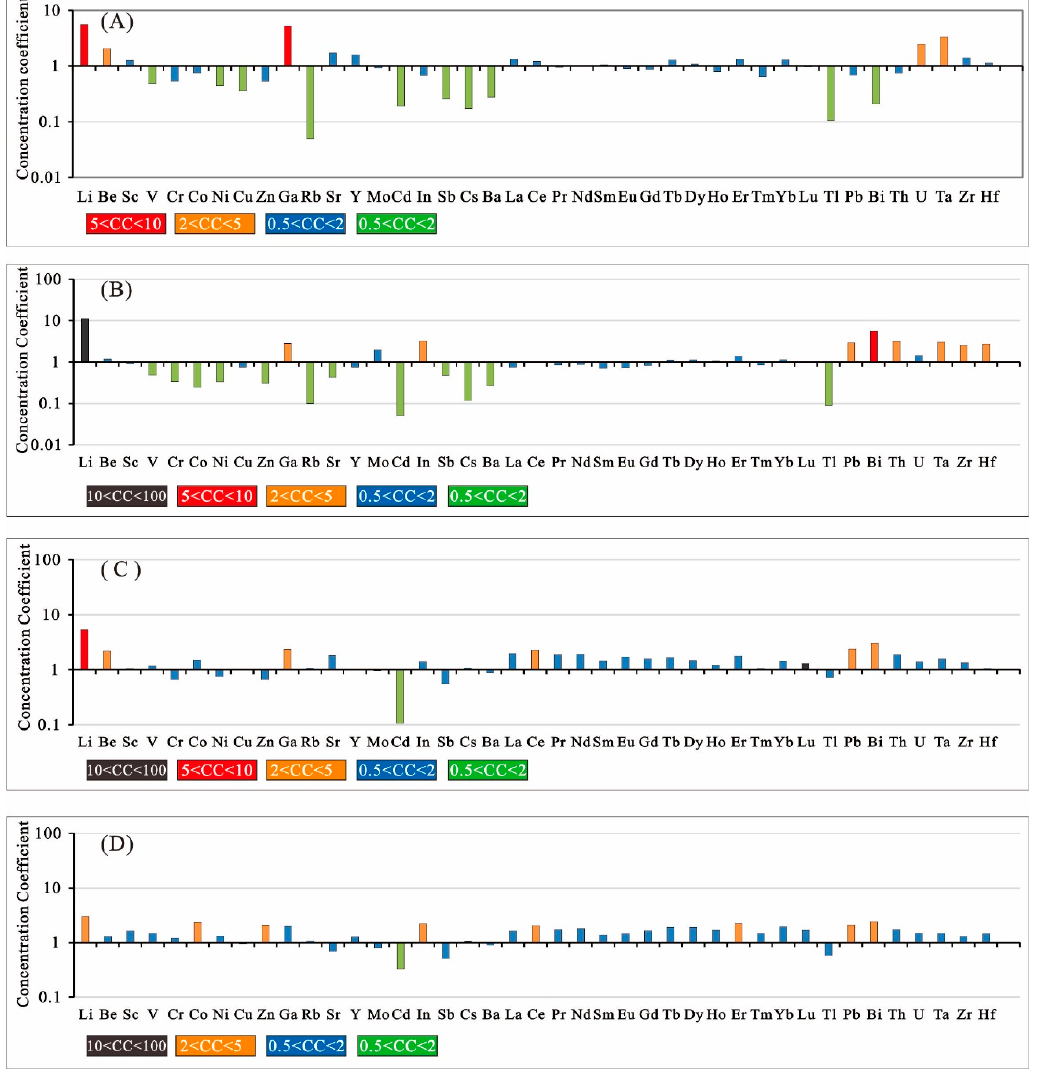
Figure 12. Concentration coefficients (CC) of the trace elements in ( A ) the coal benches, ( B ) partings, ( C ) roofs and ( D ) floor samples from Dongpo Mine. The data for the coal samples were normalized using the average trace element concentrations of world hard coals [62]. The data for the partings, roof, and floor samples were normalized using the average trace element concentrations of the world clays [66].